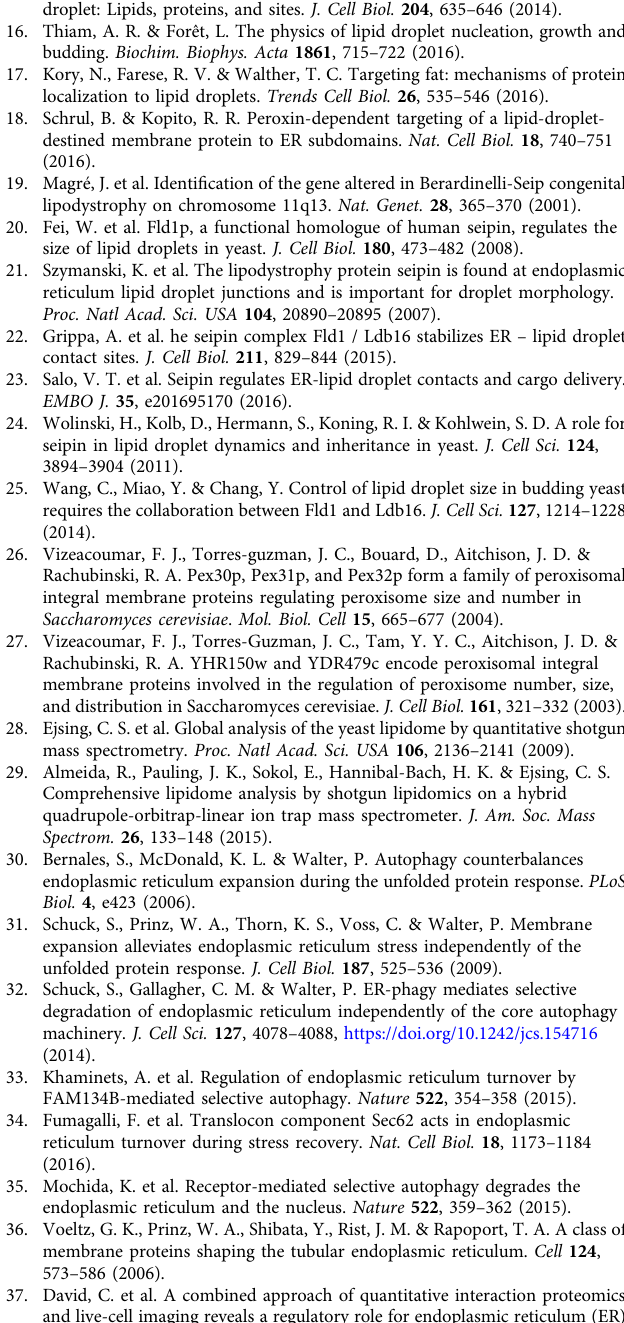
Fig. 6 Phospholipid composition of bulk ER determines organelle budding in the absence of Pex30 and seipin. a DAG levels in cells with the indicated genotype, as determined by mass spectrometry. Graph corresponds to the average of two biological ( + and ○ ) and two technical repeats. The four individual measurements are displayed. Light gray bars indicate SD. b Distribution of Bodipy-stained neutral lipids in cells with the indicated genotypes. Bar 2 µ m. c Distribution of functional peroxisomes in cells with the indicated genotype analyzed by steady-state localization of mCherry-PTS1. Bar 2 µ m. d Quanti fi cation of functional peroxisomes in cells with the indicated genotype, determined as in c . The average of two experiments is shown; error bars represent SD; > 100cells/genotype/experiment were counted. e Levels of the major phospholipids phosphotidylcholine (PC, left) and phosphatidylinositol (PI, right) in cells with the indicated genotype, as detected by mass spectrometry. Graphs correspond to the average of two biological and two technical repeats. The four individual measurements are displayed ( + ). Light gray bars indicate SD. f TAG levels in cells with the indicated genotype, as detected by mass spectrometry. Graphs correspond to the average of two biological and two technical repeats. The four individual measurements are displayed ( + ). Light gray bars